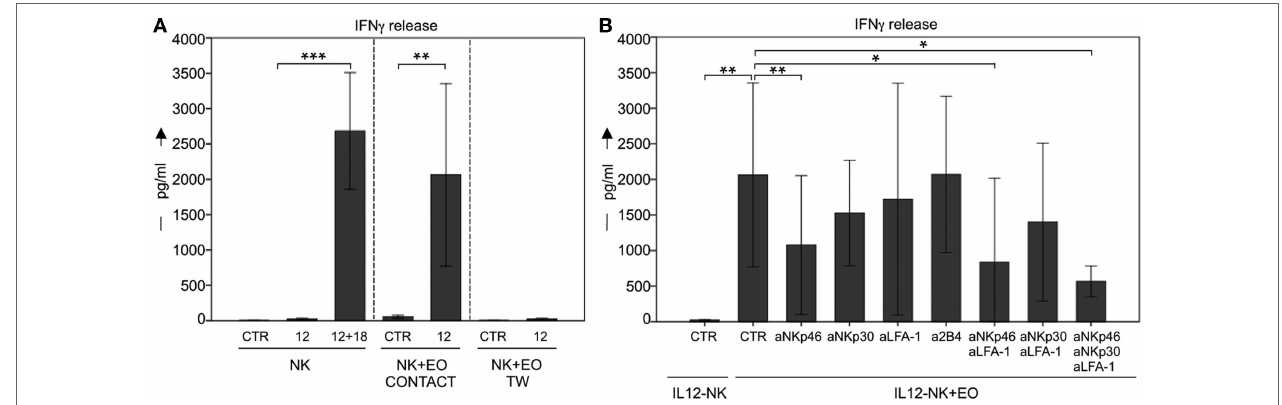
FigUre 4 | analysis of iFn- γ secretion by nK cells after coculture with eosinophils (eOs) . (a) Resting NK cells (CTR) or IL12-conditioned NK cells were cultured o.n. with EOs, either in the presence of cell-to-cell contact or in transwell. After o.n. culture, supernatants were harvested and then analyzed by ELISA for the presence of IFN γ . NK cells that had been exposed o.n. to IL12 plus IL18 were used for comparison. The NK/EOs ratio in the coculture was of 1:1. Average of six independent experiments is shown (pg/ml ± SD). ** P < 0.01; *** P < 0.001. (B) IL12-conditioned NK cells were cocultured with EOs in the absence or in the presence of the indicated blocking mAbs; after o.n. culture, supernatants were harvested and then analyzed by ELISA for the presence of IFN γ . The NK/EOs ratio in the coculture was of 1:1. Average of six independent experiments is shown (pg/ml ± SD). * P < 0.05; ** P < 0.01.